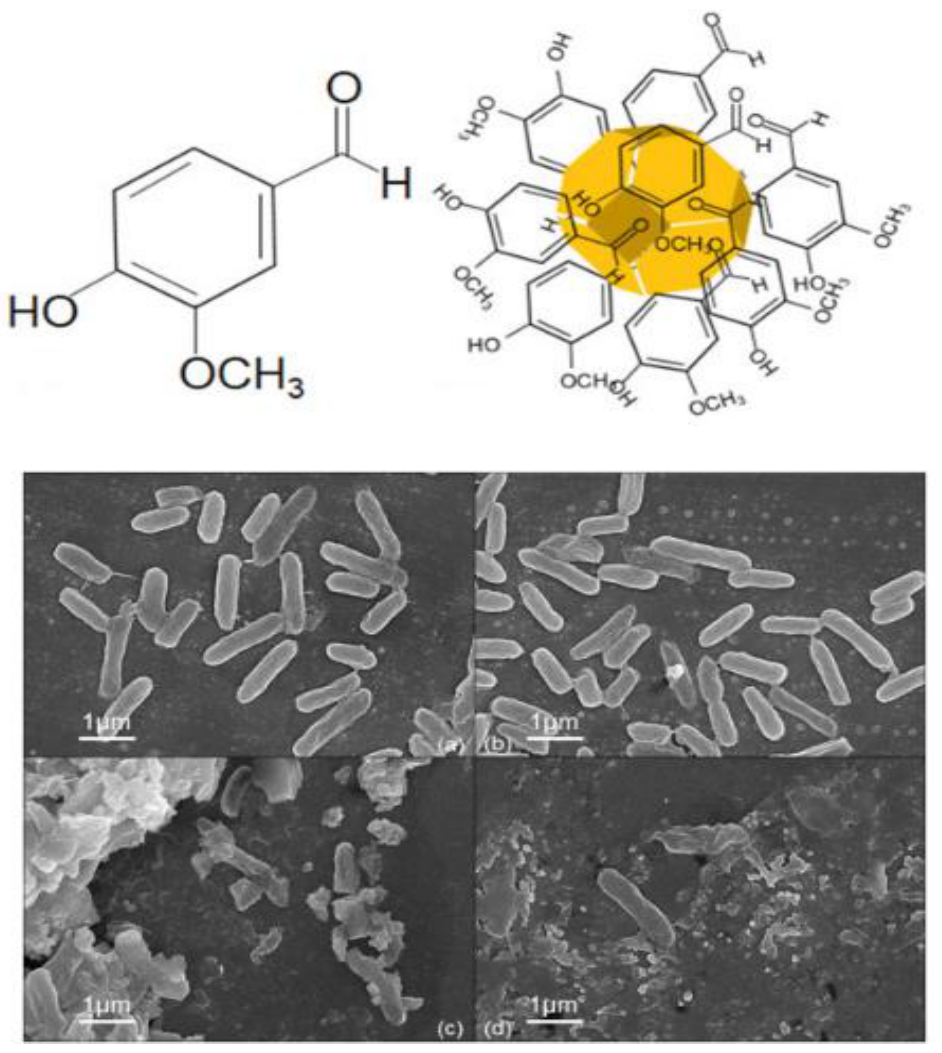
Figure 2. Schematic illustration of synthesized VAuNPs by vanillin ( the above illustration) ; FESEM image of P. aeruginosa in untreated, in presence of the ( a ) 50 µ g/mL of VAuNPs, ( b ) Meropenem- 200 µ g/mL, ( c ) Meropenem (20 µ g/mL) and ( d ) VAuNPs (50 µ g/mL) ( the below images ) [43]. Reprinted with permission from